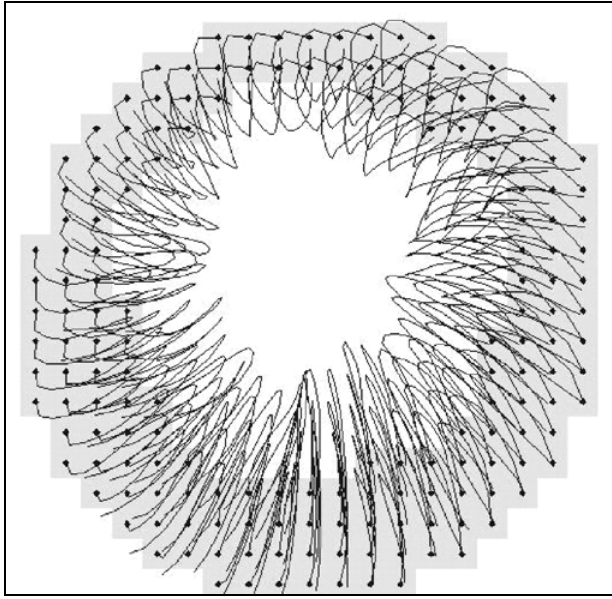
Fig. 9. Myocardial motion trajectories for a mid-ventricular short-axis view of a healthy volunteer. The septum is centred at 9 o’clock in the image.